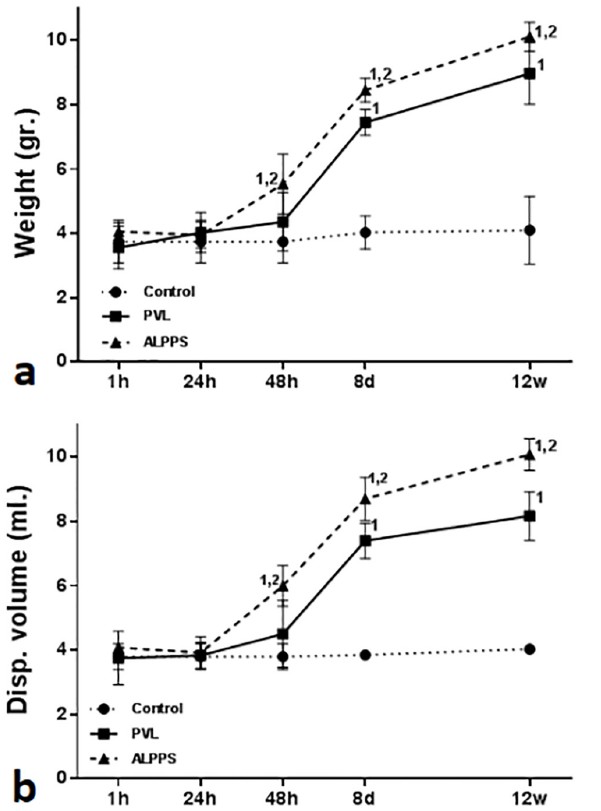
Fig 3. Morphometric evolution of weight and displaced volume of the controls, PVL and ALPPS FLR. ( a ) There is an increasing of the weight of PVL and ALPPS FLR from 48 hours post-surgery, but significantly higher in this last group. ( b ) Regarding the evaluation of the displacement volume the same results are observed. Mann-Whitney U-test (n = 6 animals per group). The numbers (1, 2) indicate significant differences of the considered group in comparison with control (1) and PVL (2) groups, respectively. A p value of < 0.05 was considered as